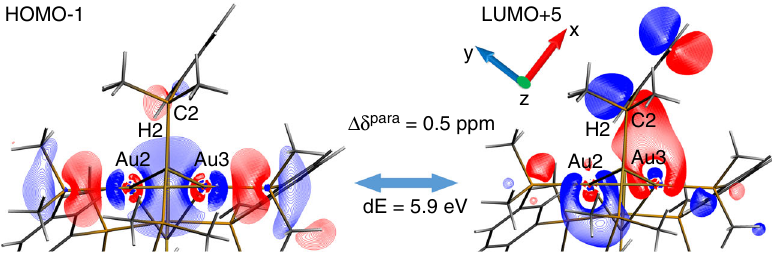
Fig. 2 An example of Ramsey-type MO ↔ MO* coupling in 1 ′ . Orbitals are cut along Au2 – H2 – Au3